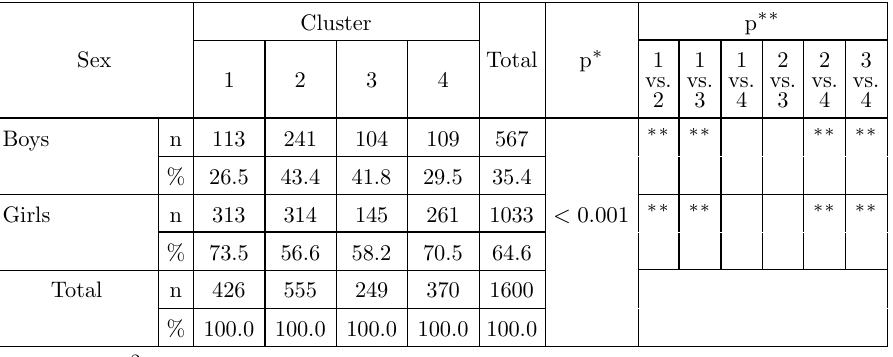
Test for two proportions with a Bonferroni correction for multiple comparisons, p < 0 .